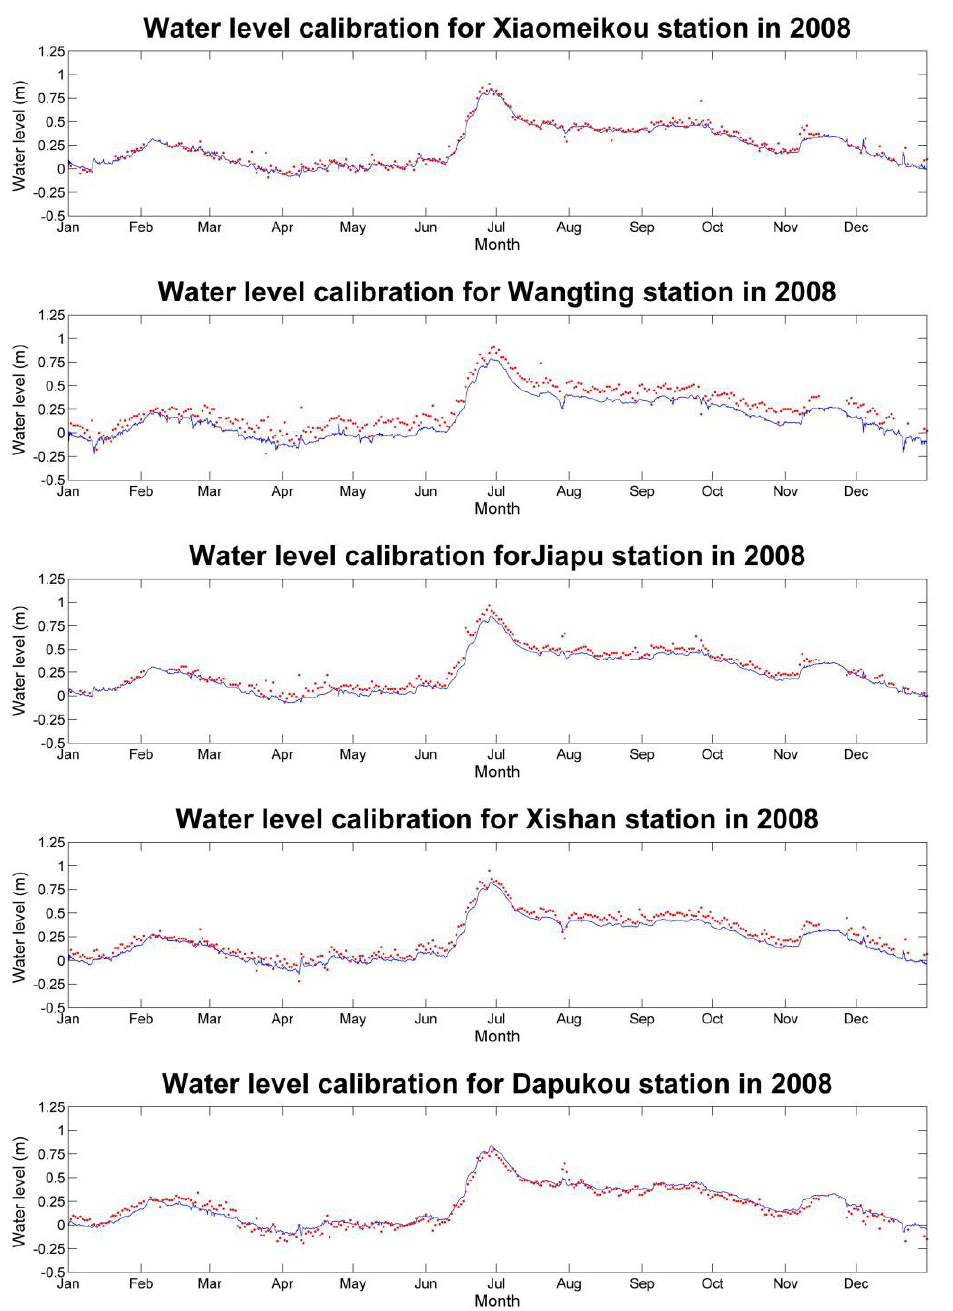
Figure 3. In situ measured and modeled water level for five monitoring stations in 2008, water levels are based on Wusong Datum. Measured levels are shown with points, and model results are shown with solid lines.